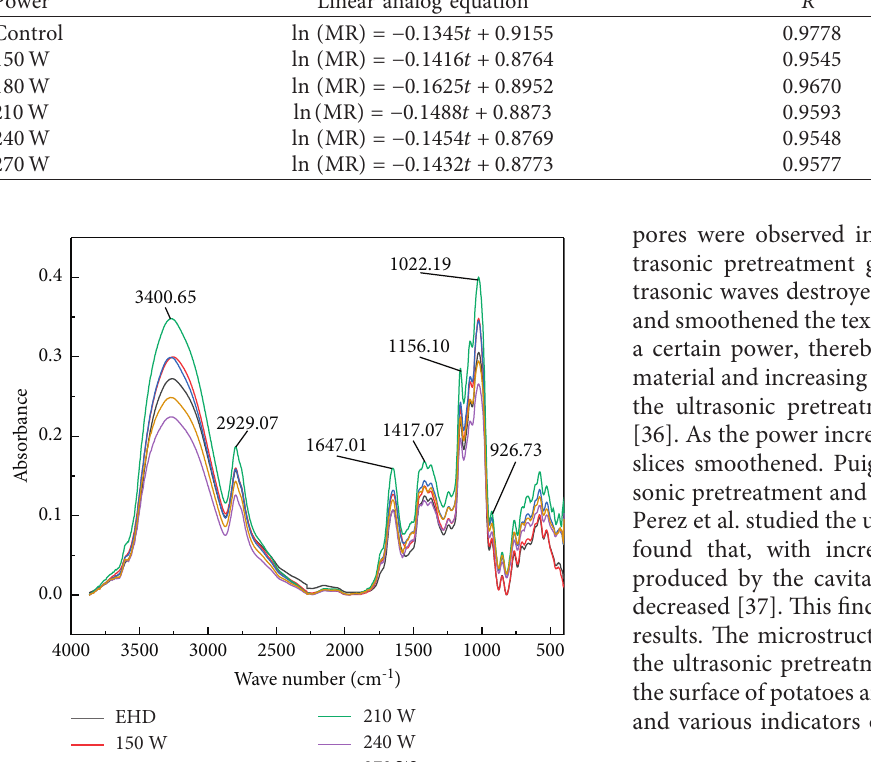
Table 3: Effect of different ultrasonic power pretreatment conditions on the effective moisture diffusion coefficient of potato slices. Power